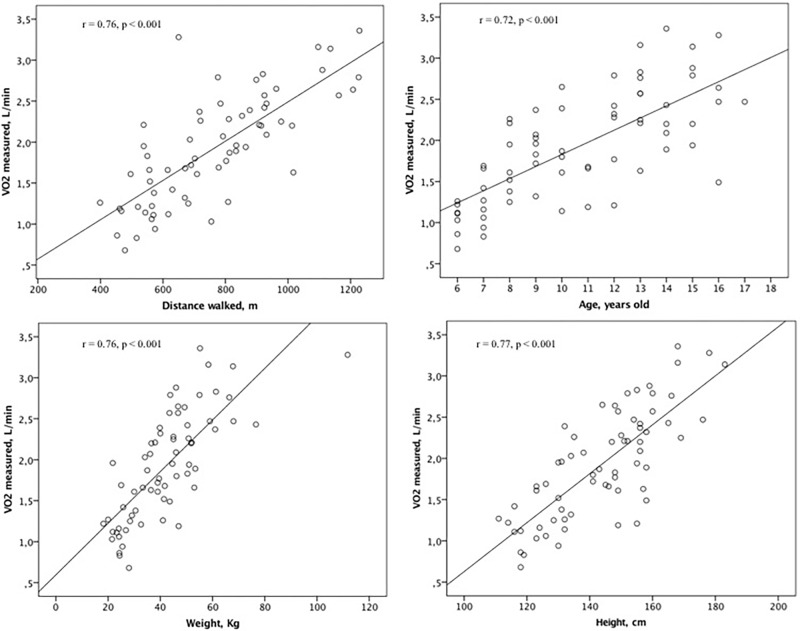
Association between VO2peak, distance walked, age, weight, and height for the equation group.